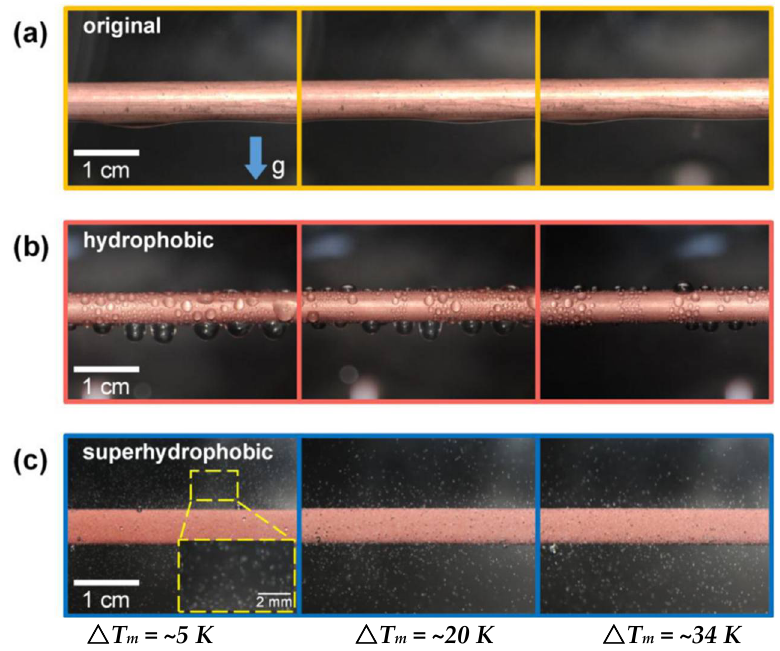
Figure 25. The condensation behaviors on the original ( a ), hydrophobic ( b ), and superhydrophobic surfaces ( c ) with the subcooling increasing. Reprinted with permission from Ref [122]. Copyright